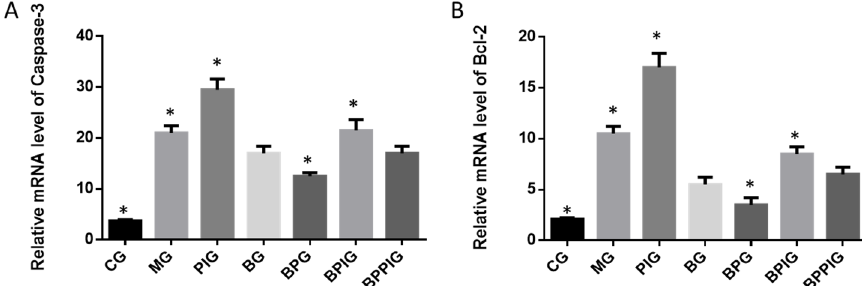
Figure 8. Real-time quantitative RT-PCR analysis of the mRNA levels of SREBP-1c/PNPLA-3 pathway and its interacting molecules. ( A ) Relative mRNA level of PPAR- α ; ( B ) Relative mRNA level of SREBP-1C; ( C ) Relative mRNA level of PNPLA3. Eight liver samples were analyzed in each group. All data are presented as mean value ± S.D. * p < 0.05 via a blueberry juice group BG.